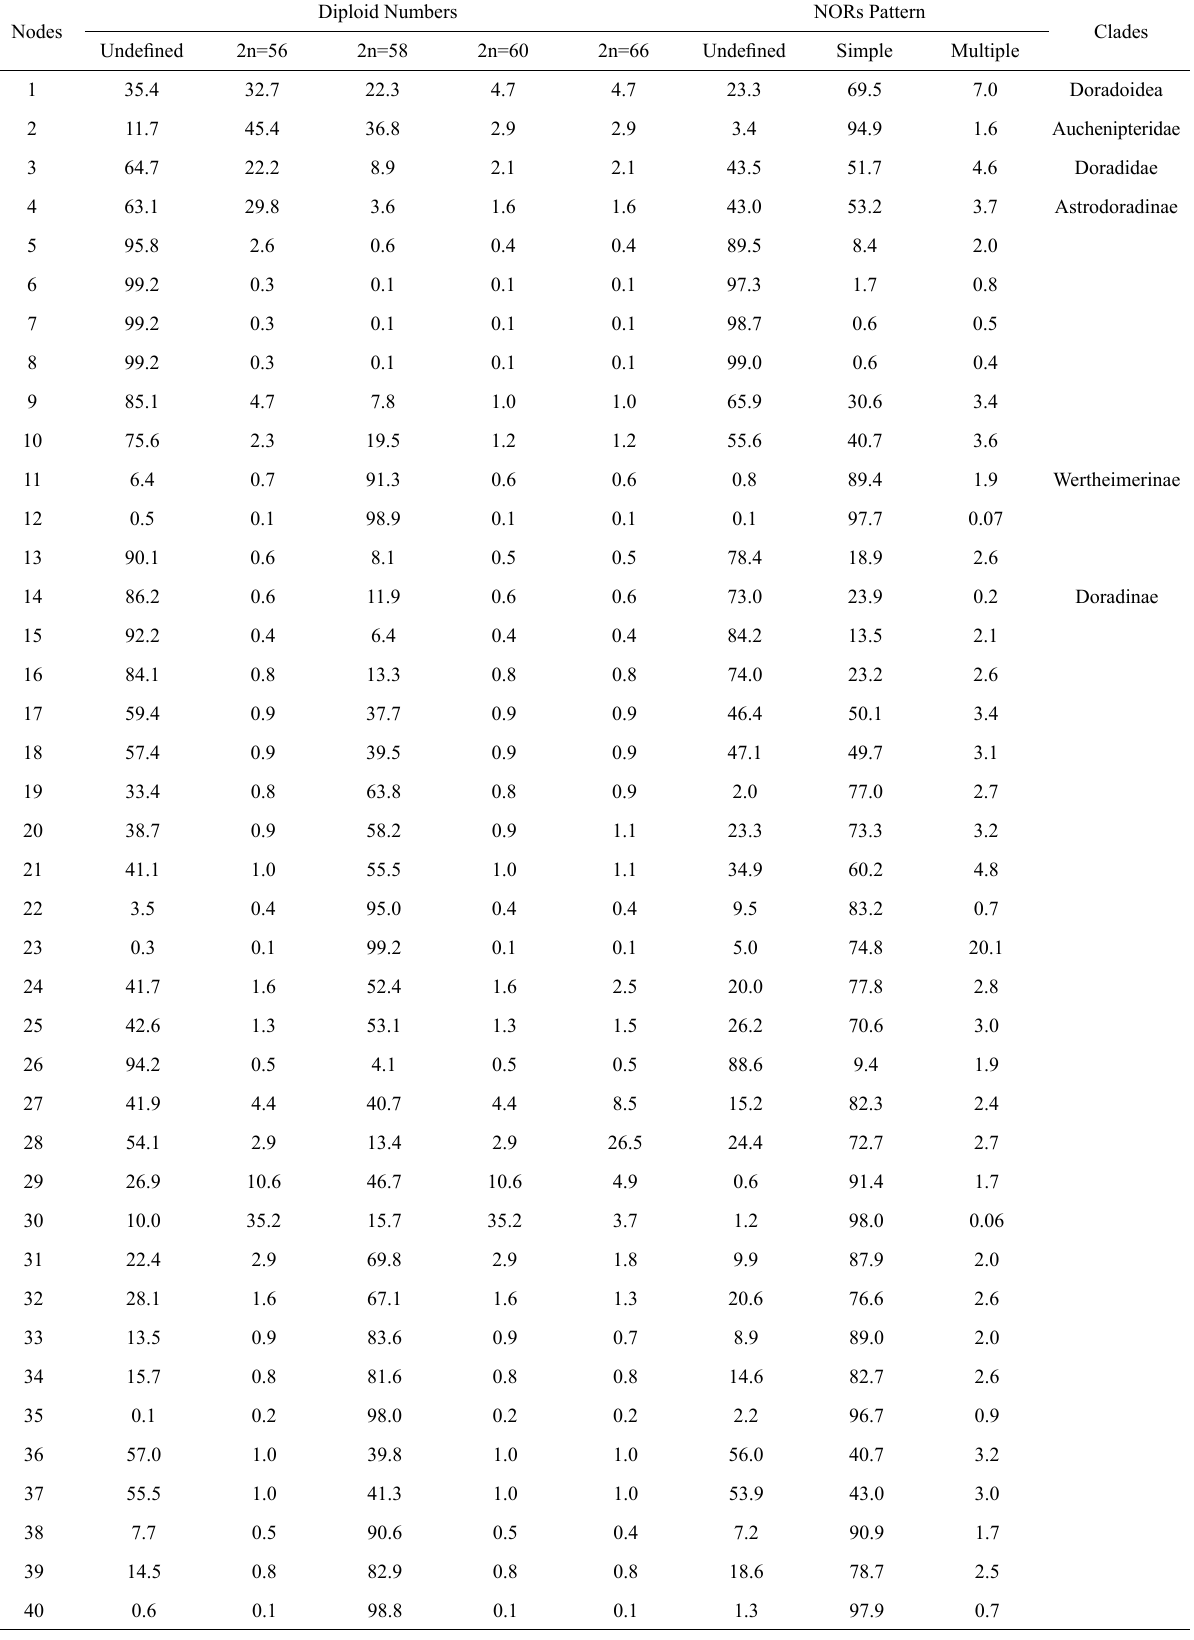
Table 4 – Probabilistic values calculated after, maximum likelihood ancestral state reconstructions of diploid number and NORs pattern, based on Mk1 model using the Mesquite software in Doradidae species. The values highlighted in red, are the most probably ancestral character for each node.